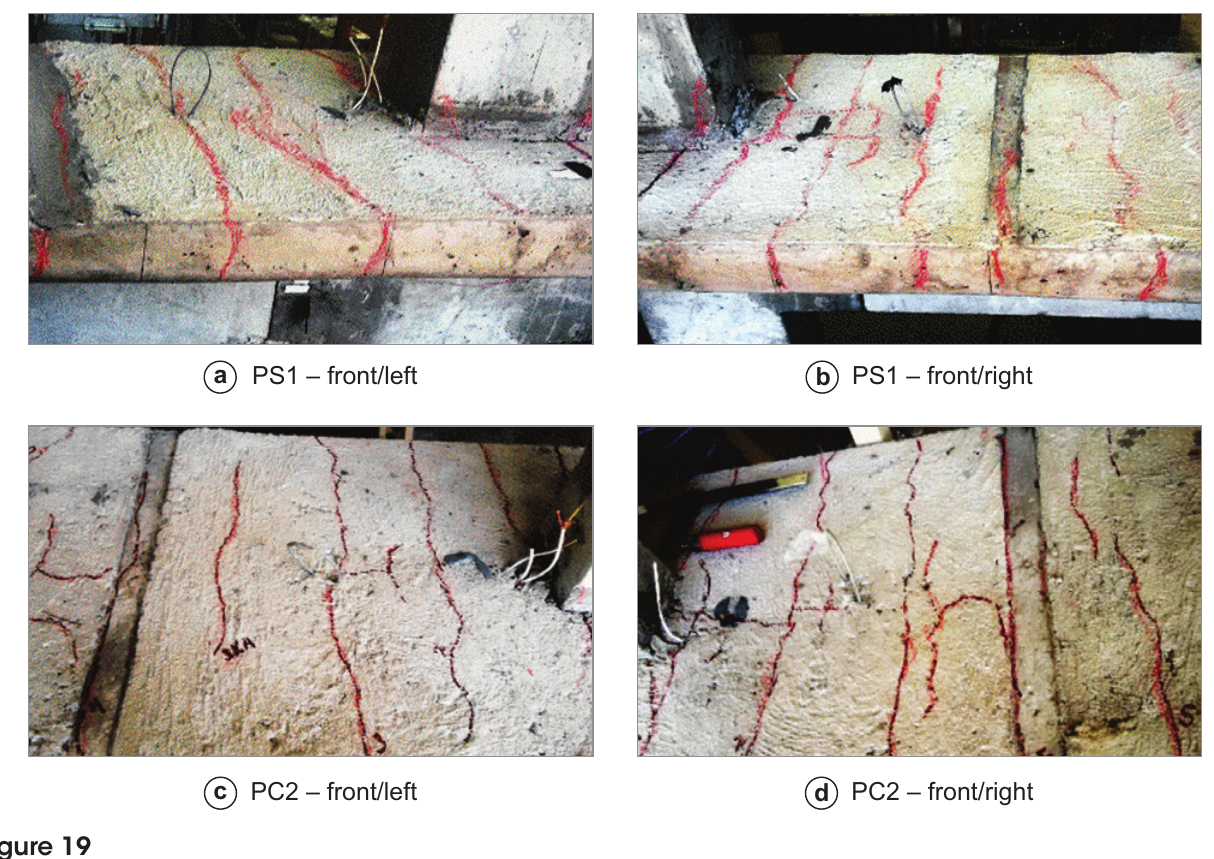
Cracking pattern of the specimens PS and PC